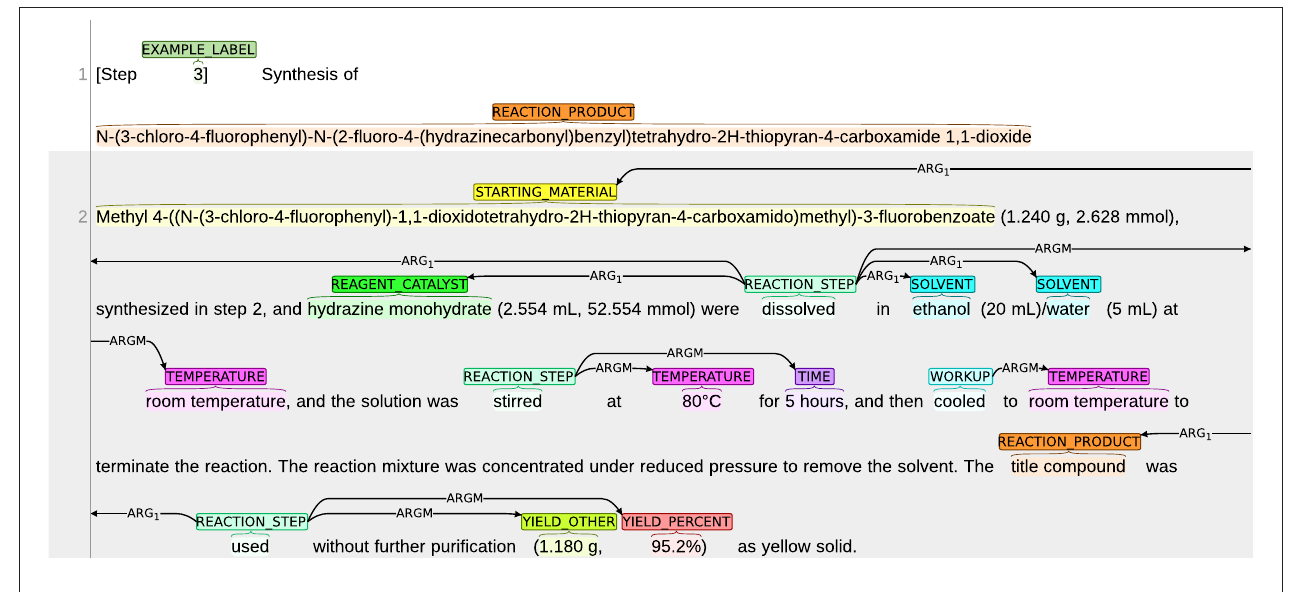
FIGURE 2 | Visualization of the annotations in the snippet in Figure 1